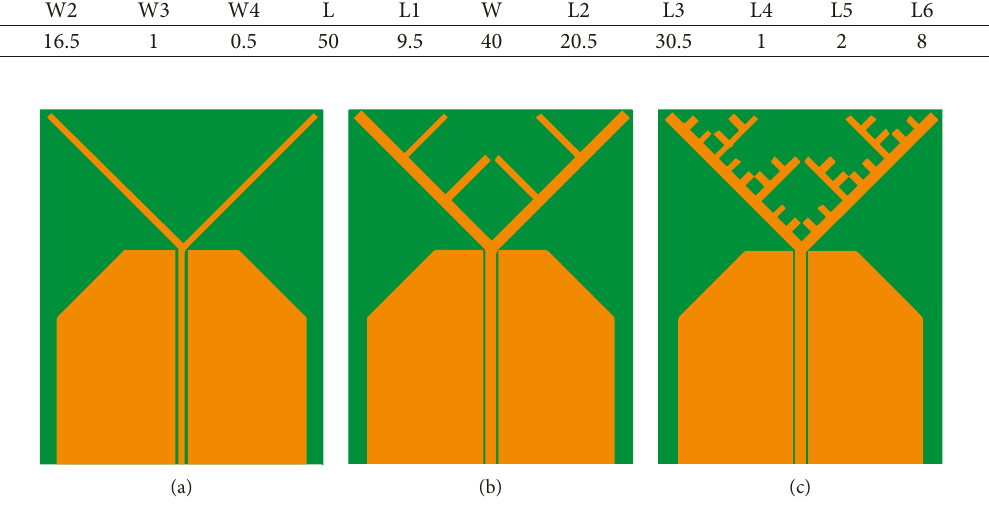
Figure 3: Proposed antenna in the stepwise iteration stages. (a) No iteration. (b) 1st iteration. (c) 2nd iteration.